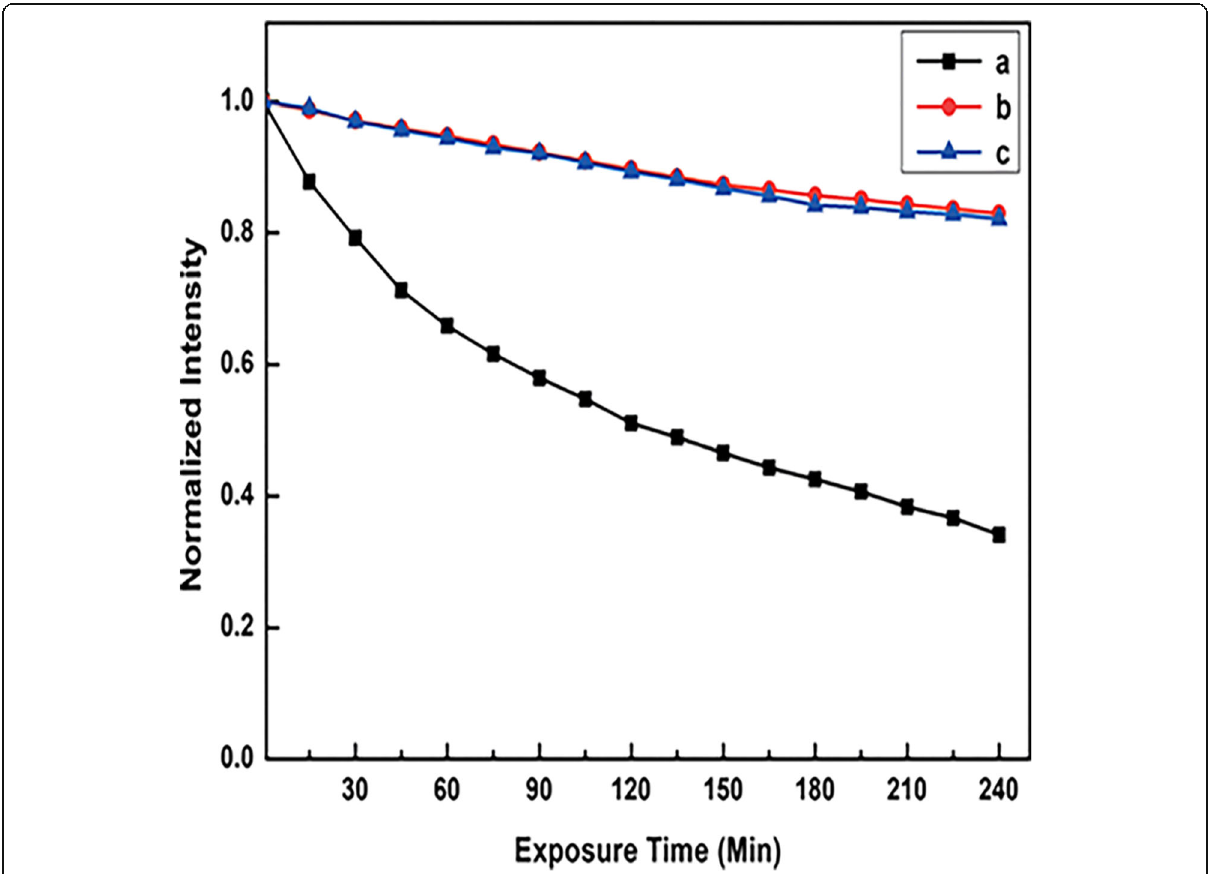
Fig. 4 The curves of fluorescence intensity changing with exposure time under 365 nm irradiation, a parent Eu complex in CHCl 3 solution, b Eu@Si-NH 2 , and c Eu@Si-OH nanoparticles in phosphate-buffered saline (PBS) buffer solution